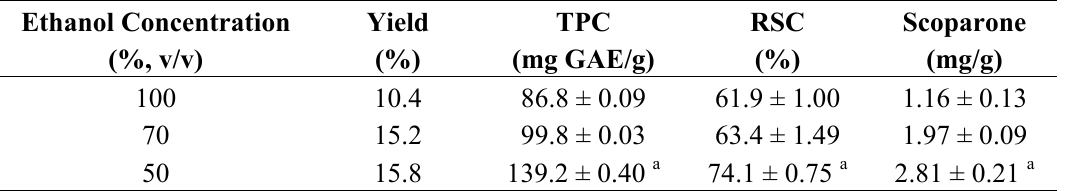
Table 1. TPC, antioxidant activity and scoparone in different ethanol